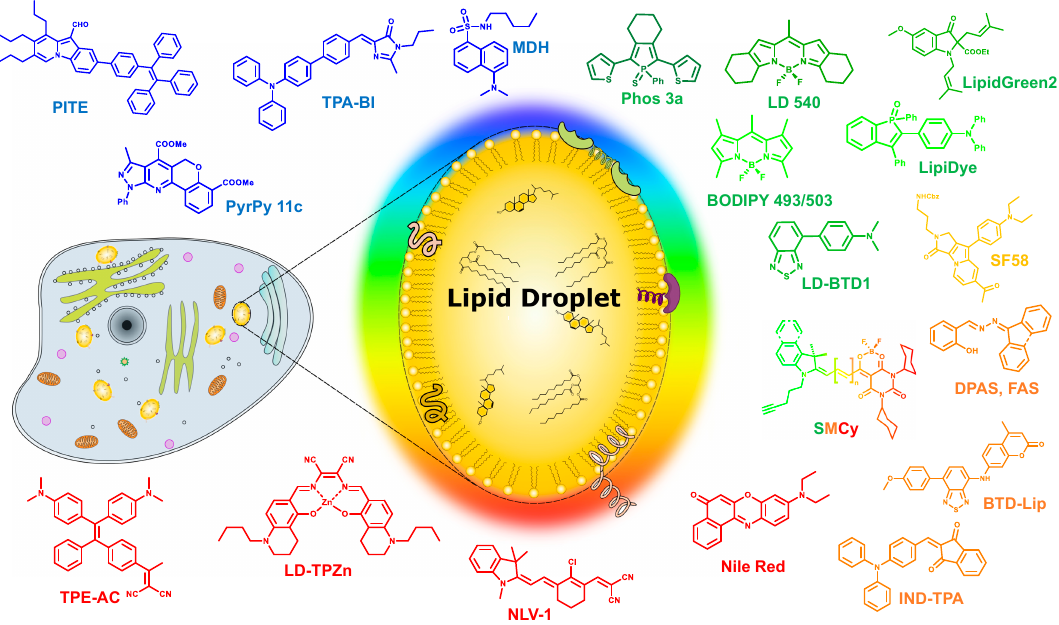
Figure 1. Schematic representation of a lipid droplet and the various multicolor liquid droplets (LDs) probes discussed in this review.